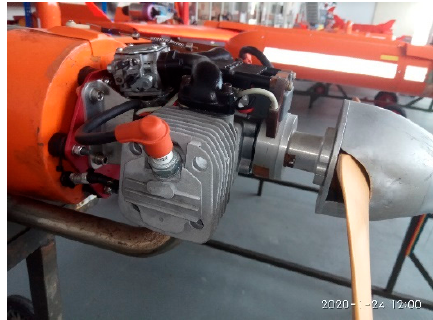
Figure 5. Original ALO internal combustion engine with a two-blade wooden propeller. Table 7. Electric engine characteristics.